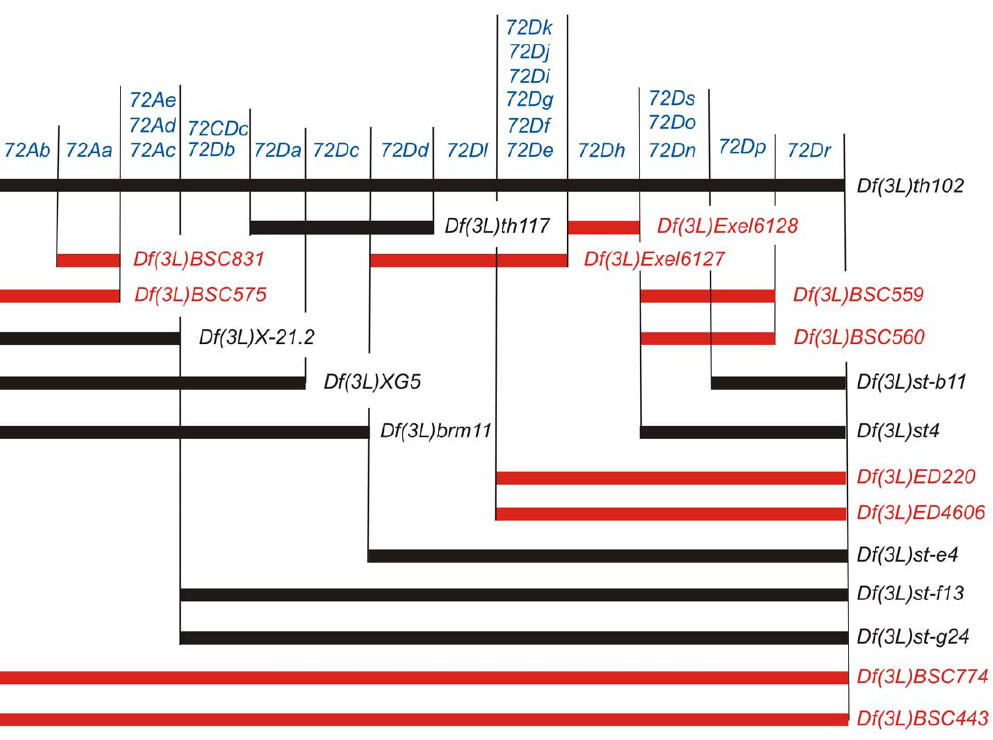
Figure 1. Complementation of essential genes with a set of deletions that overlap Df(3L)th102 . The essential genes are listed at the top of the map in blue, with a horizontal bar for each deletion indicating which genes failed to complement that deletion. Deletions with molecularly characterized breakpoints are indicated by red bars. Deletions with no molecular information are indicated by black bars.